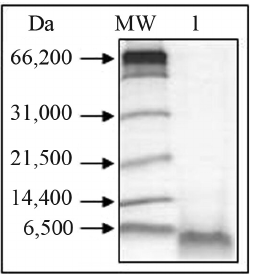
Figure 2 - Three-phase SDS-Tricine-PAGE of Cell Wall Extracts (CWE) from fully expanded leaves of Samara bell pepper variety, after ammo- nium sulfate precipitation followed by heating fractionation and dialysis (line 1). MM was 5 (cid:2) L of the Wide-Range Molecular Weight Markers (Bio-Rad,USA).TheproteinbandswerestainedwithCoomassieBrilliant Blue